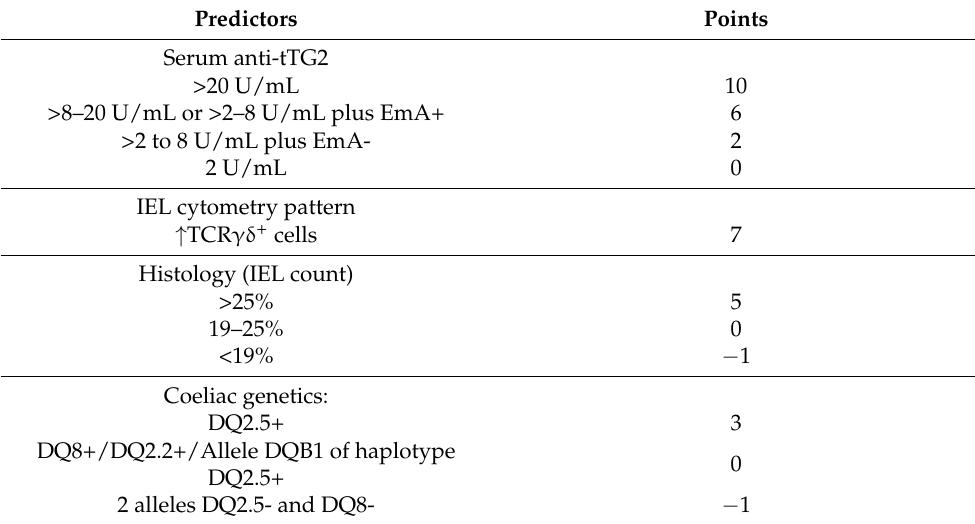
Table 1. The low-grade coeliac scoring system ( − 2 to 25 points): a score >10 points is considered positive